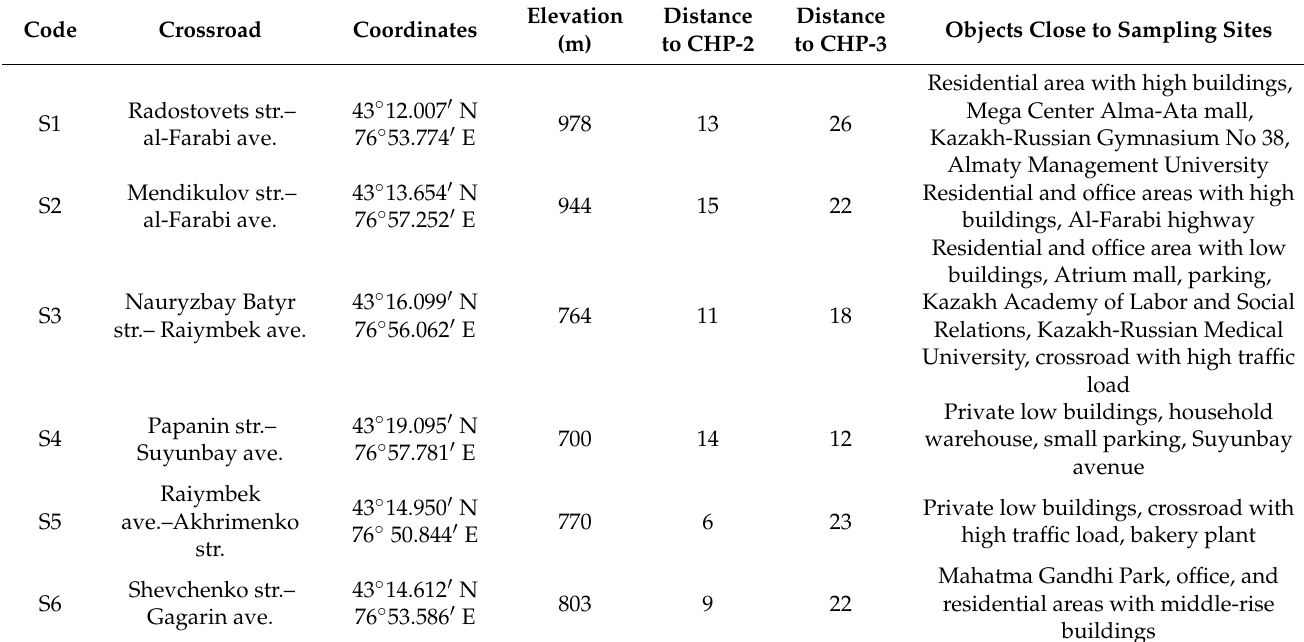
build the map for the primary dataset. As a secondary dataset, the digital elevation model (DEM) of Almaty was used. The DEM was obtained from United States Geological Survey and Shuttle Radar Topography Mission data.